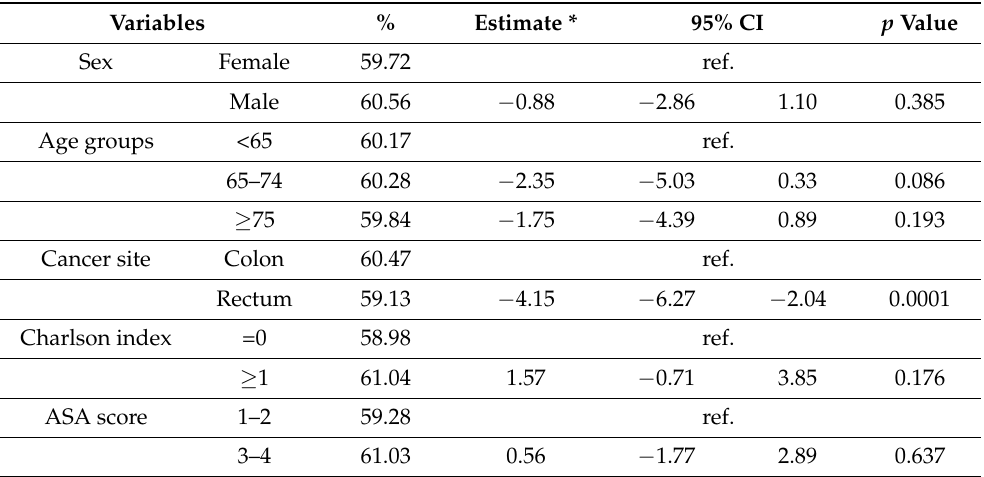
Table 3. Level of compliance (%) to all the ERAS items by patient demographic and clinical character-